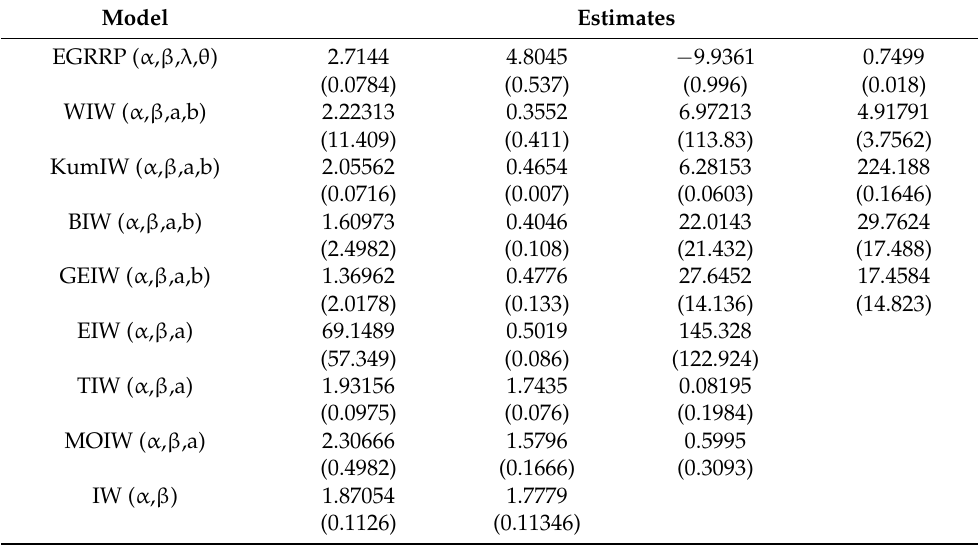
Table 10. MLEs and their standard errors (in parentheses) for the 1 st